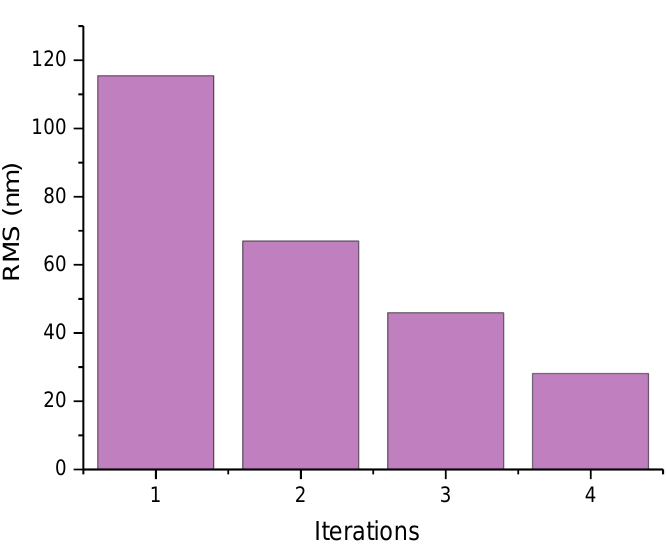
Figure 6. Machining example of a CPP substrate: ( a ) prescribed surface: PV = 1326.2 nm, RMS = 292.2 nm; ( b ) plasma- processed surface, PV = 1306. 4 nm, RMS = 286.5 nm; ( c ) interferometer measurement; ( d ) plasma-processed residual errors of the CPP.